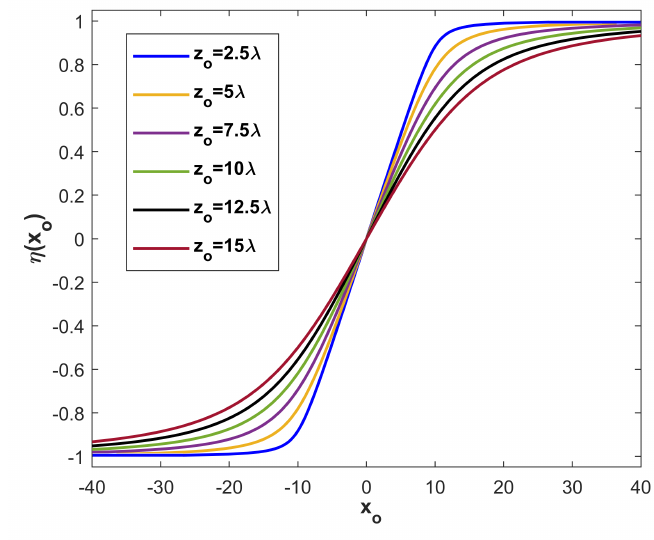
Figure A1. Diagram of η ( x o ) for different values of z o when a = 10 λ